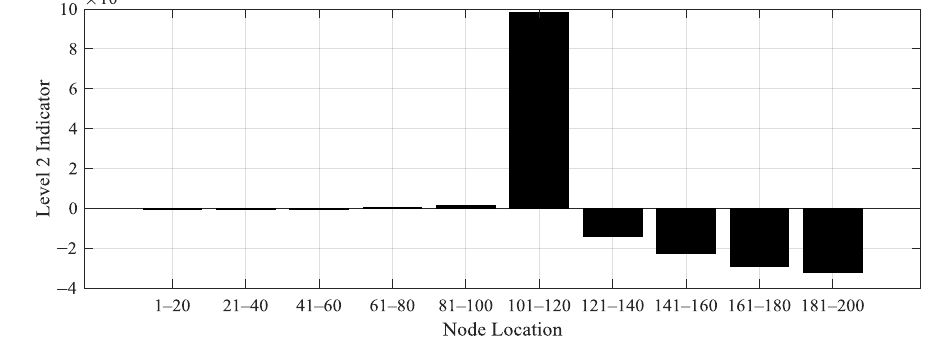
Figure 23. Level 2 damage indicator for Case 4.